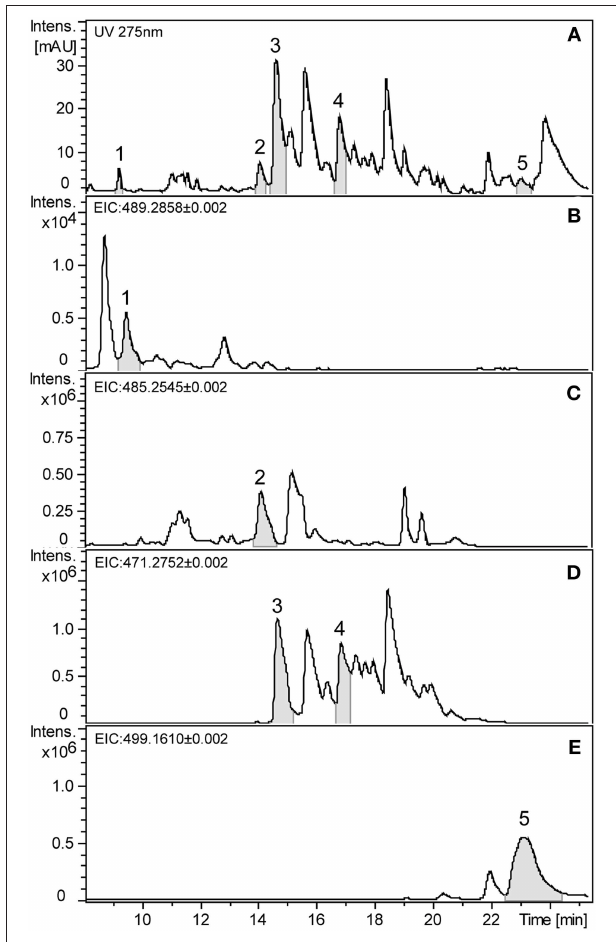
FIGURE 2 | Representative chromatograms of E. globulus leaf extract showing FPCs. (A) UHPLC-UV chromatogram at 275nm. (B) Extracted ion chromatogram (EIC) in negative mode of the m/z 489.2858 showing macrocarpal J ( 1 ). (C) EIC of the m/z 485.2545 showing macrocarpal N ( 2 ). (D) EIC of the m/z 471.2752 showing macrocarpal A ( 3 ) and L ( 4 ). (E) EIC of the m/z 499.1610 showing sideroxylonal A ( 5 ).